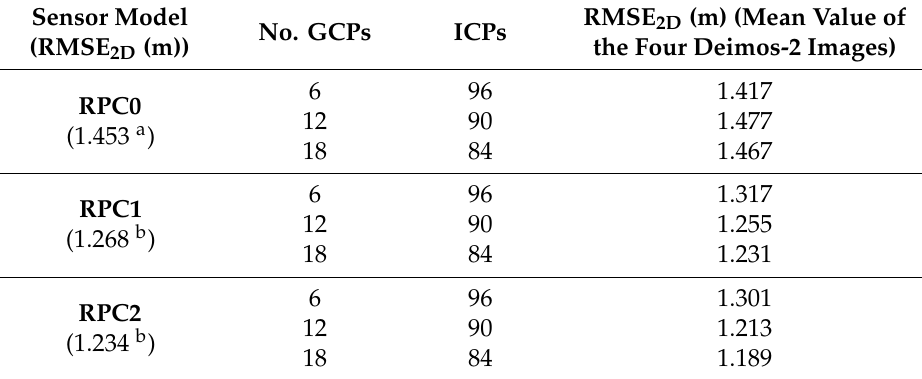
Table 4. Comparison of mean values of RMSE 2D computed at ICPs from Deimos-2 PAN images depending on the number of GCPs (no. GCPs). For each sensor model tested, mean values of RMSE 2D in brackets followed by di ff erent superscript letters indicate significant di ff erences at a significance level p <